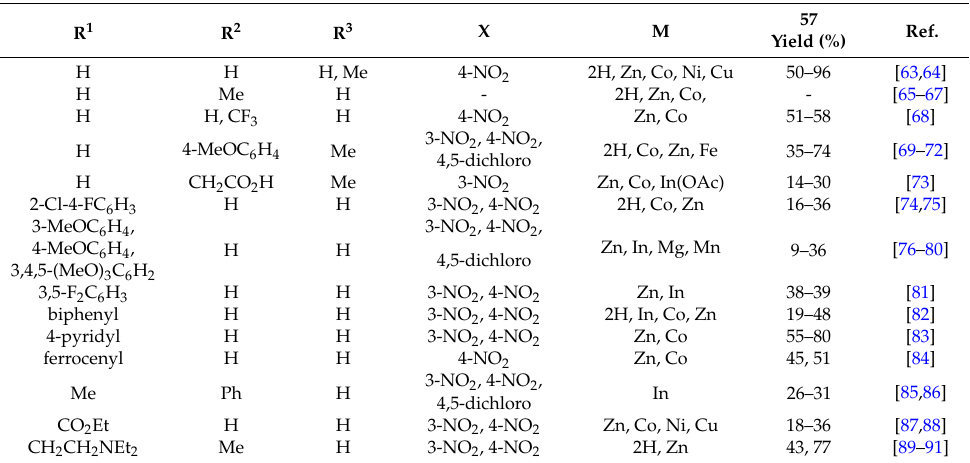
Table 1. Starting materials and yields of coumarin–phthalocyanine conjugates 57 . R 1 R